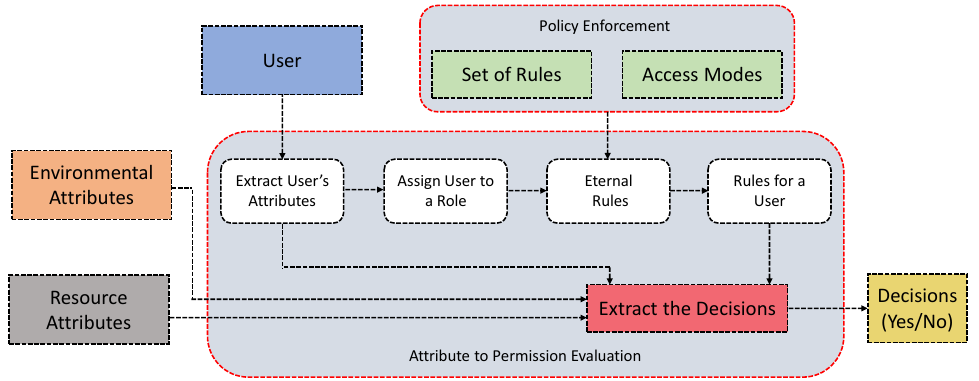
Figure 6. An HyBAC model for resource sharing in IoT discussed in